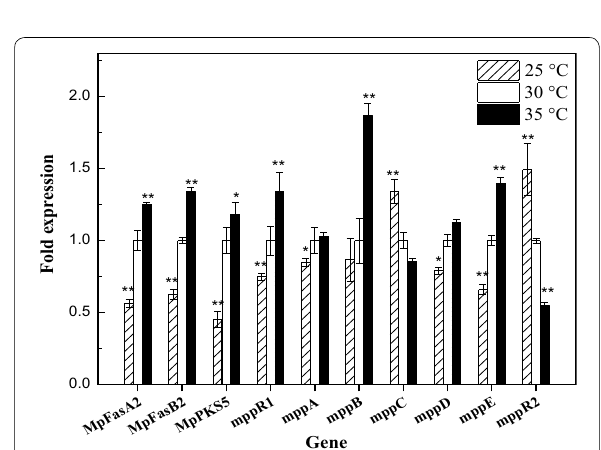
Fig. 5 Relative expression levels of the pigment biosynthesis related genes MpFasA2, MpFasB2, MpPKS5, mppR1, mppA, mppB, mppC, mppD, mppE and mppR2 as monitored by qRT-PCR. Error bars represent the standard deviation (n 3). ** p < 0.01; * p < =